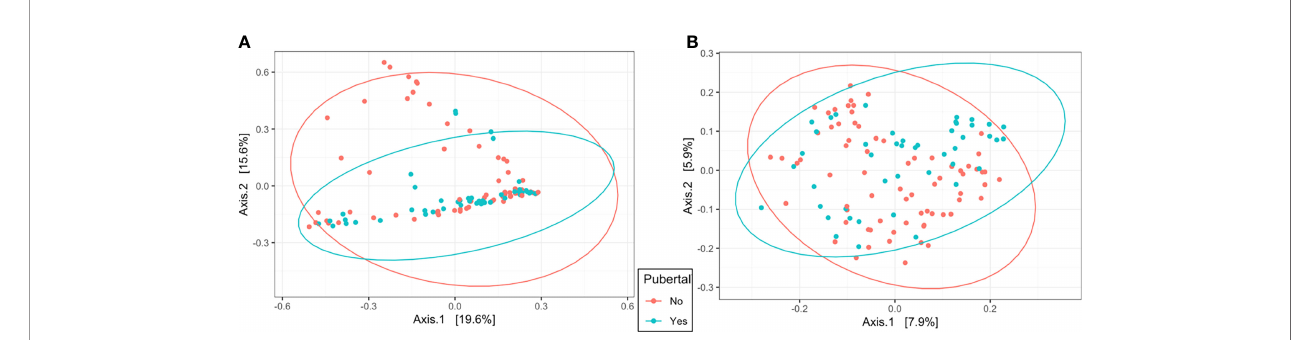
FIGURE 4 | Beta diversity by principal coordinate analysis with Bray Curtis distances for pubertal status in the uterus ( A ; R 2 = 0.03, P = 0.001) and rumen ( B ; R 2 = 0.02, P = 0.01). Signi fi cance was determined by PERMANOVA with 999 permutations. Ellipses represent 95% con fi dence interval.